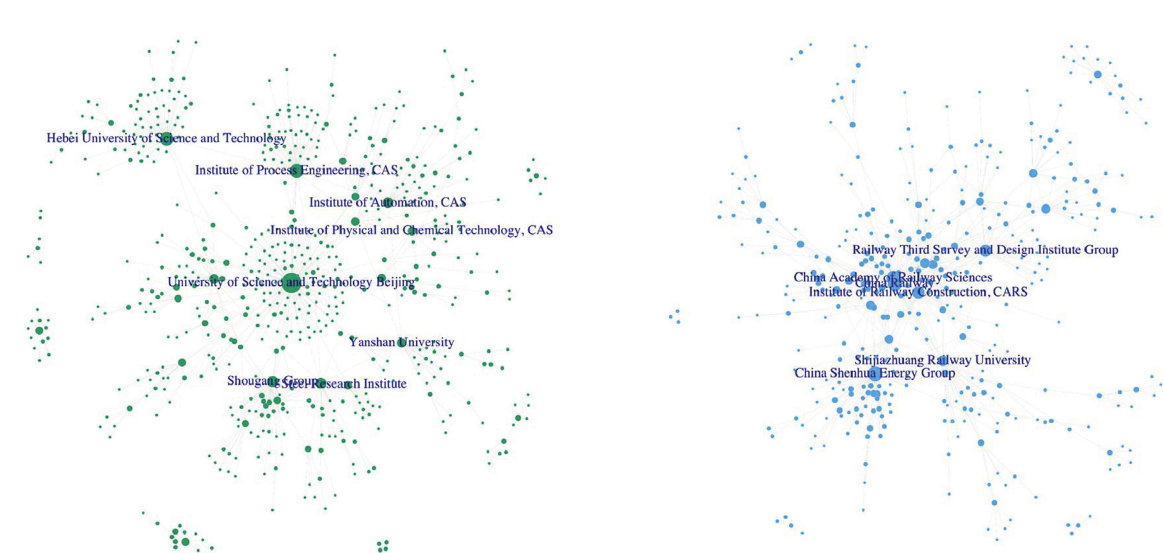
Figure 16: Community in the field of railway.